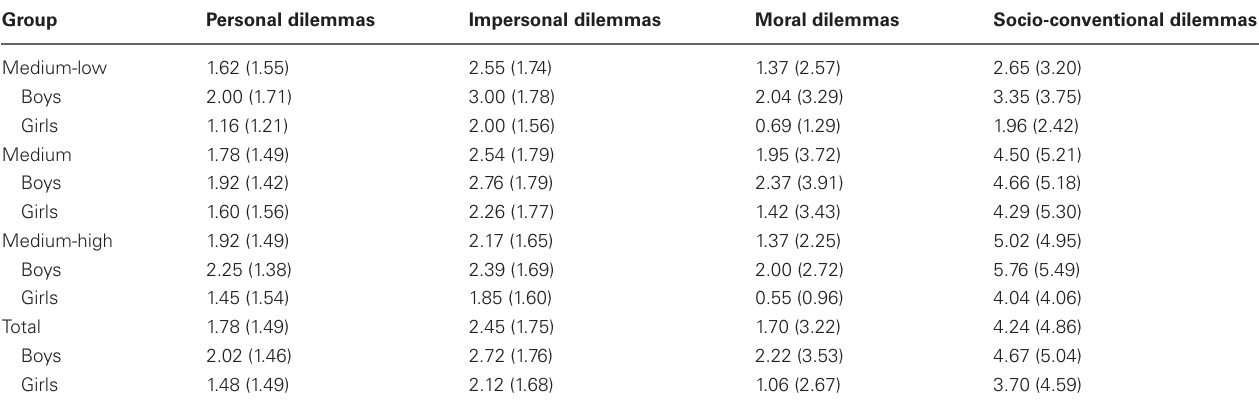
Table 6 | Mean scores (and standard deviations) of personal vs. impersonal dilemmas and moral vs. socio-conventional dilemmas in ANOVA including SES as fixed factor.